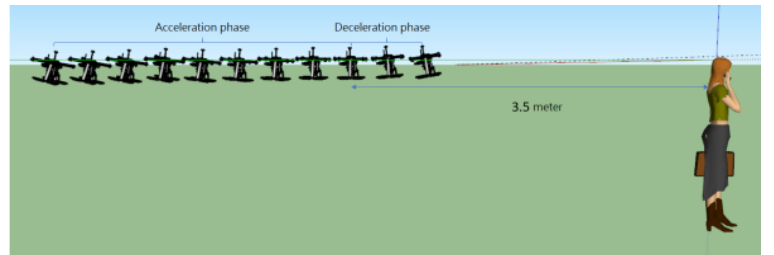
Figure 10. Graphical explanation of the target follower.